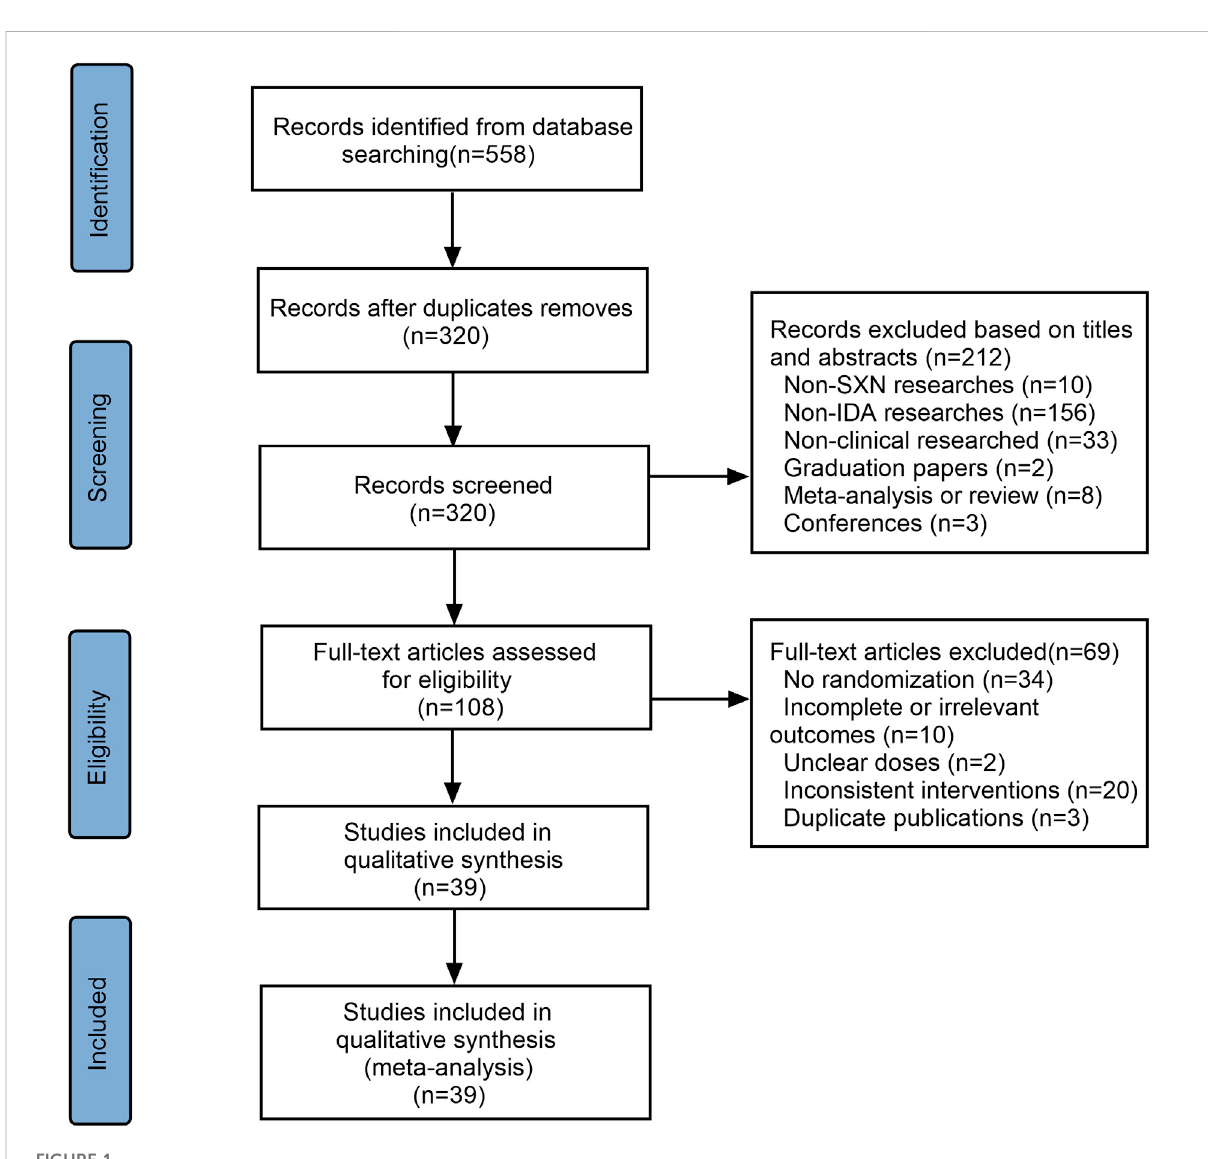
FIGURE 1 Flowchart showing the selection of trials for the meta-analysis and systematic